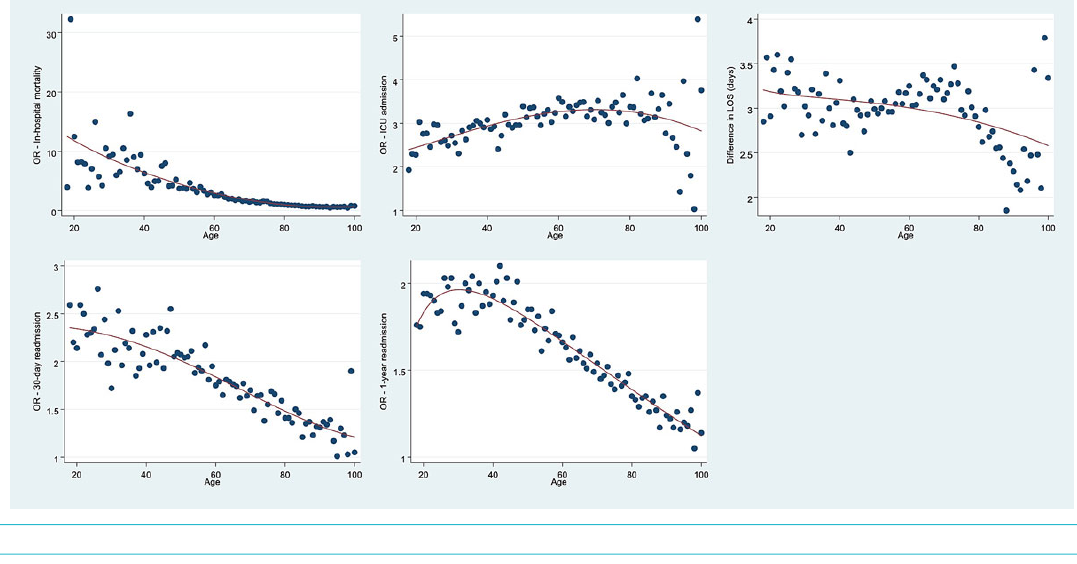
Figure S1: Age-dependent primary and secondary outcome analyses (odds ratios) on a continuous scale.